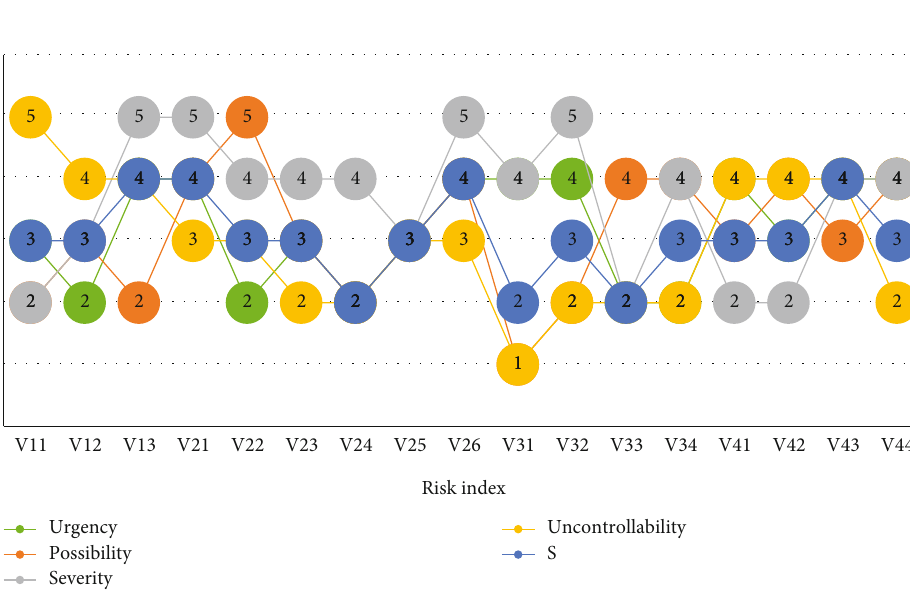
Figure 6: The change of weight obtained by di ff erent